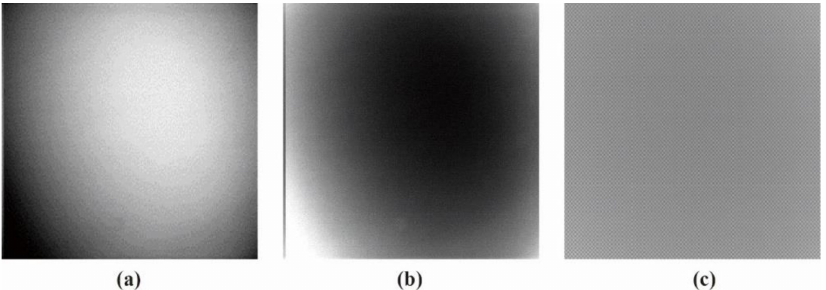
Figure 7. A comparison of the MCA-0 images ( a ) before and ( c ) after vignetting correction based on the correction factor image ( b ).